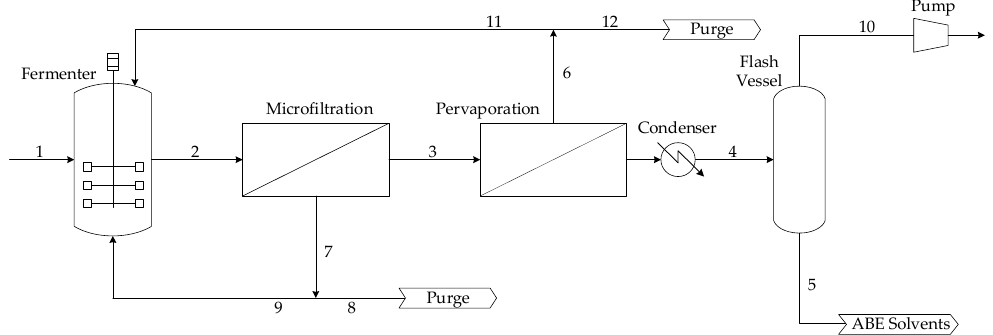
Figure 1. Schematic diagram of the butanol fermentation system integrated with a membrane pervaporation separation unit. Numbers correspond to process streams.